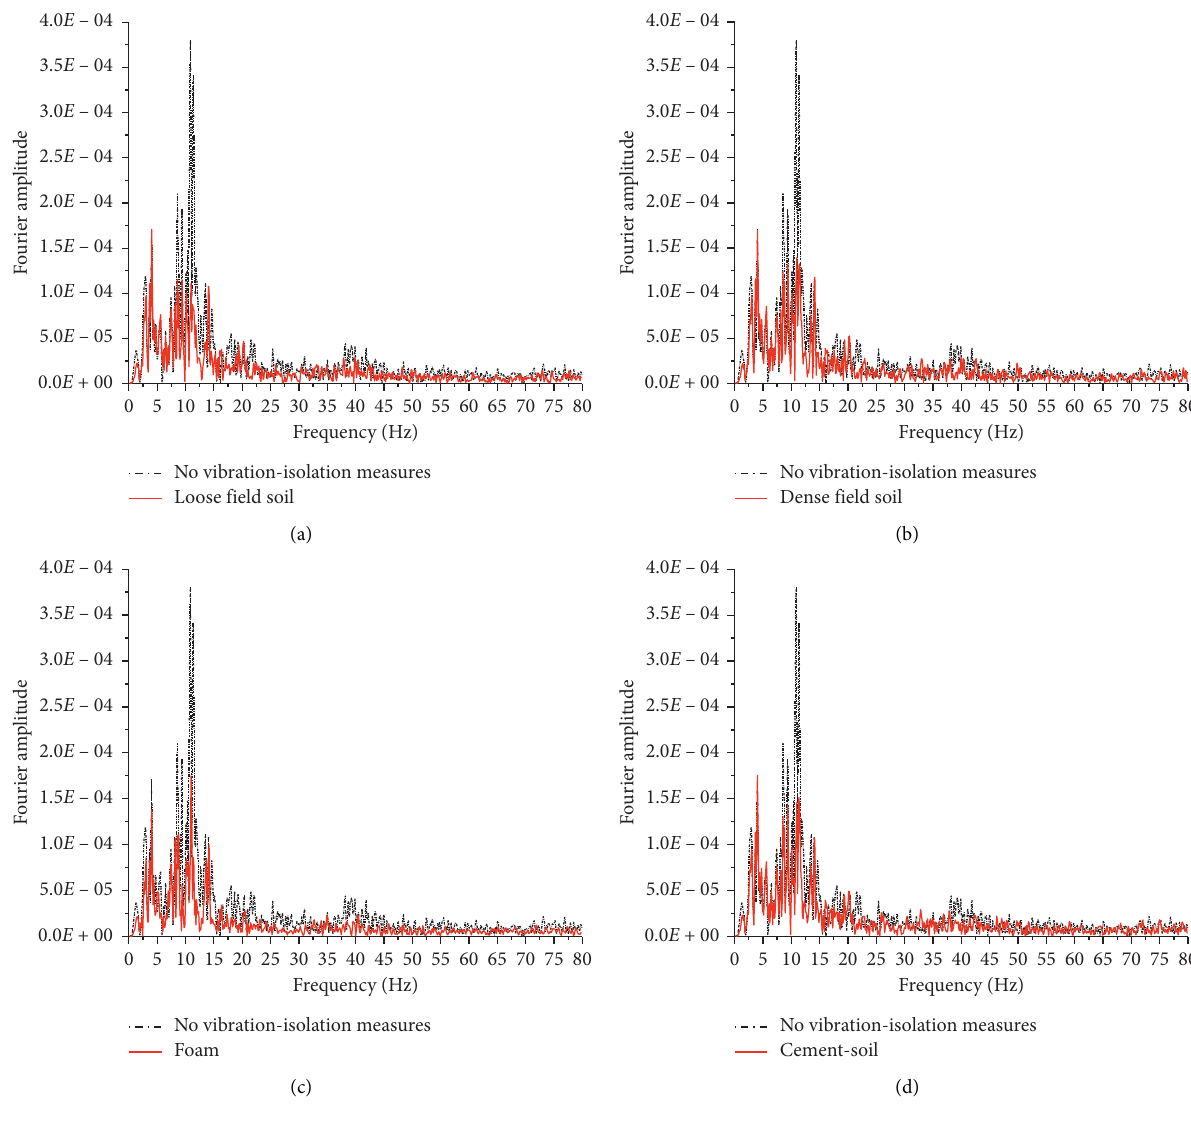
Figure 31: Influence of filling material on vibration-isolation effect (comparison of frequency spectra).